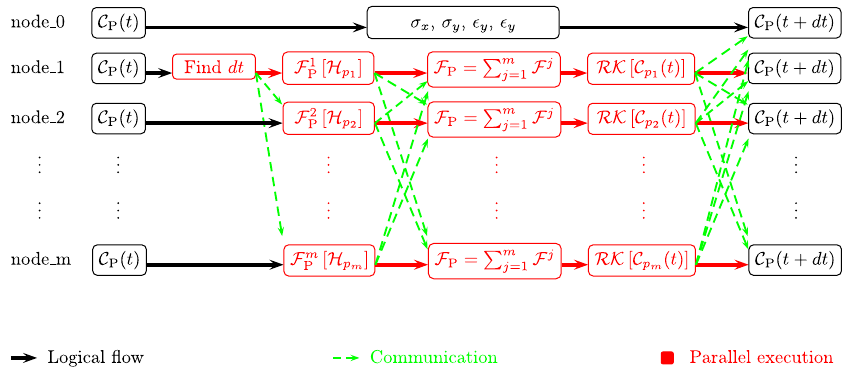
FIG. 1. (Color) Sketch of RETAR logical